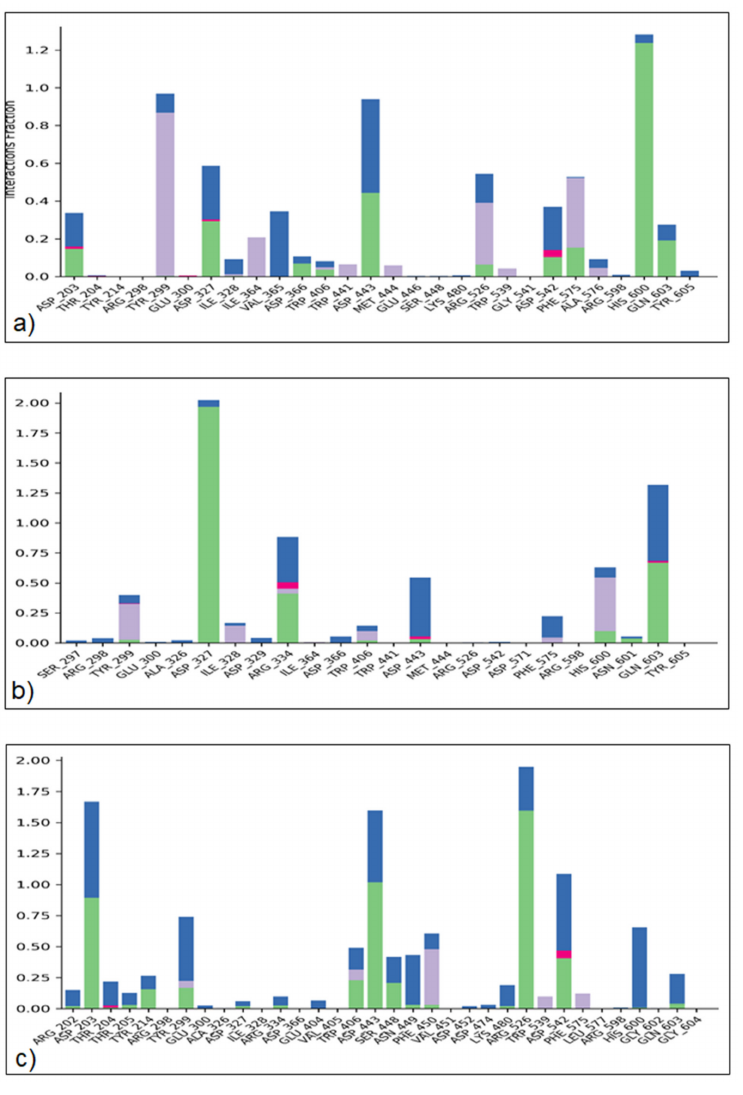
Figure 6. Protein-ligand contact interaction profile analyzed for kaempferol/alpha-glucosidase ( a ), gallic acid/alpha-glucosidase complex ( b ) and acarbose/alpha-glucosidase ( c ), respectively. Green = hydrogen bonding, pink = ionic interaction, grey = hydrophobic interaction and blue = water